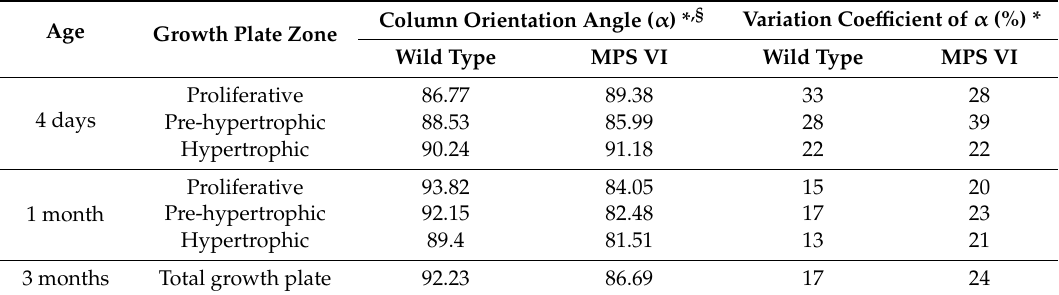
Table 2. Column orientation angle and coefficient of variation for wild type and MPS VI growth plates. Age